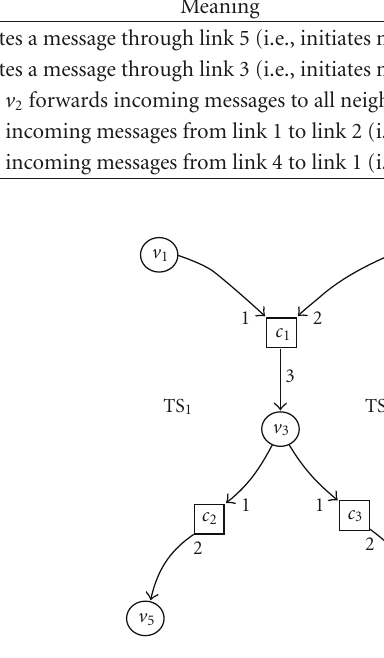
Figure 7: Example of common nodes between two trapping